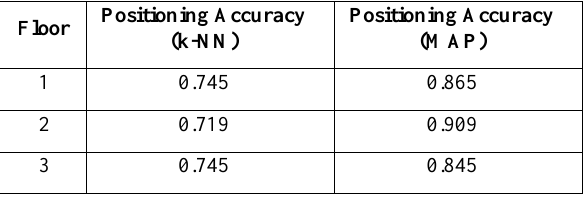
Table 1. Indoor positioning results represented by the probability of correctly locating a person to the nearest location in the fingerprint